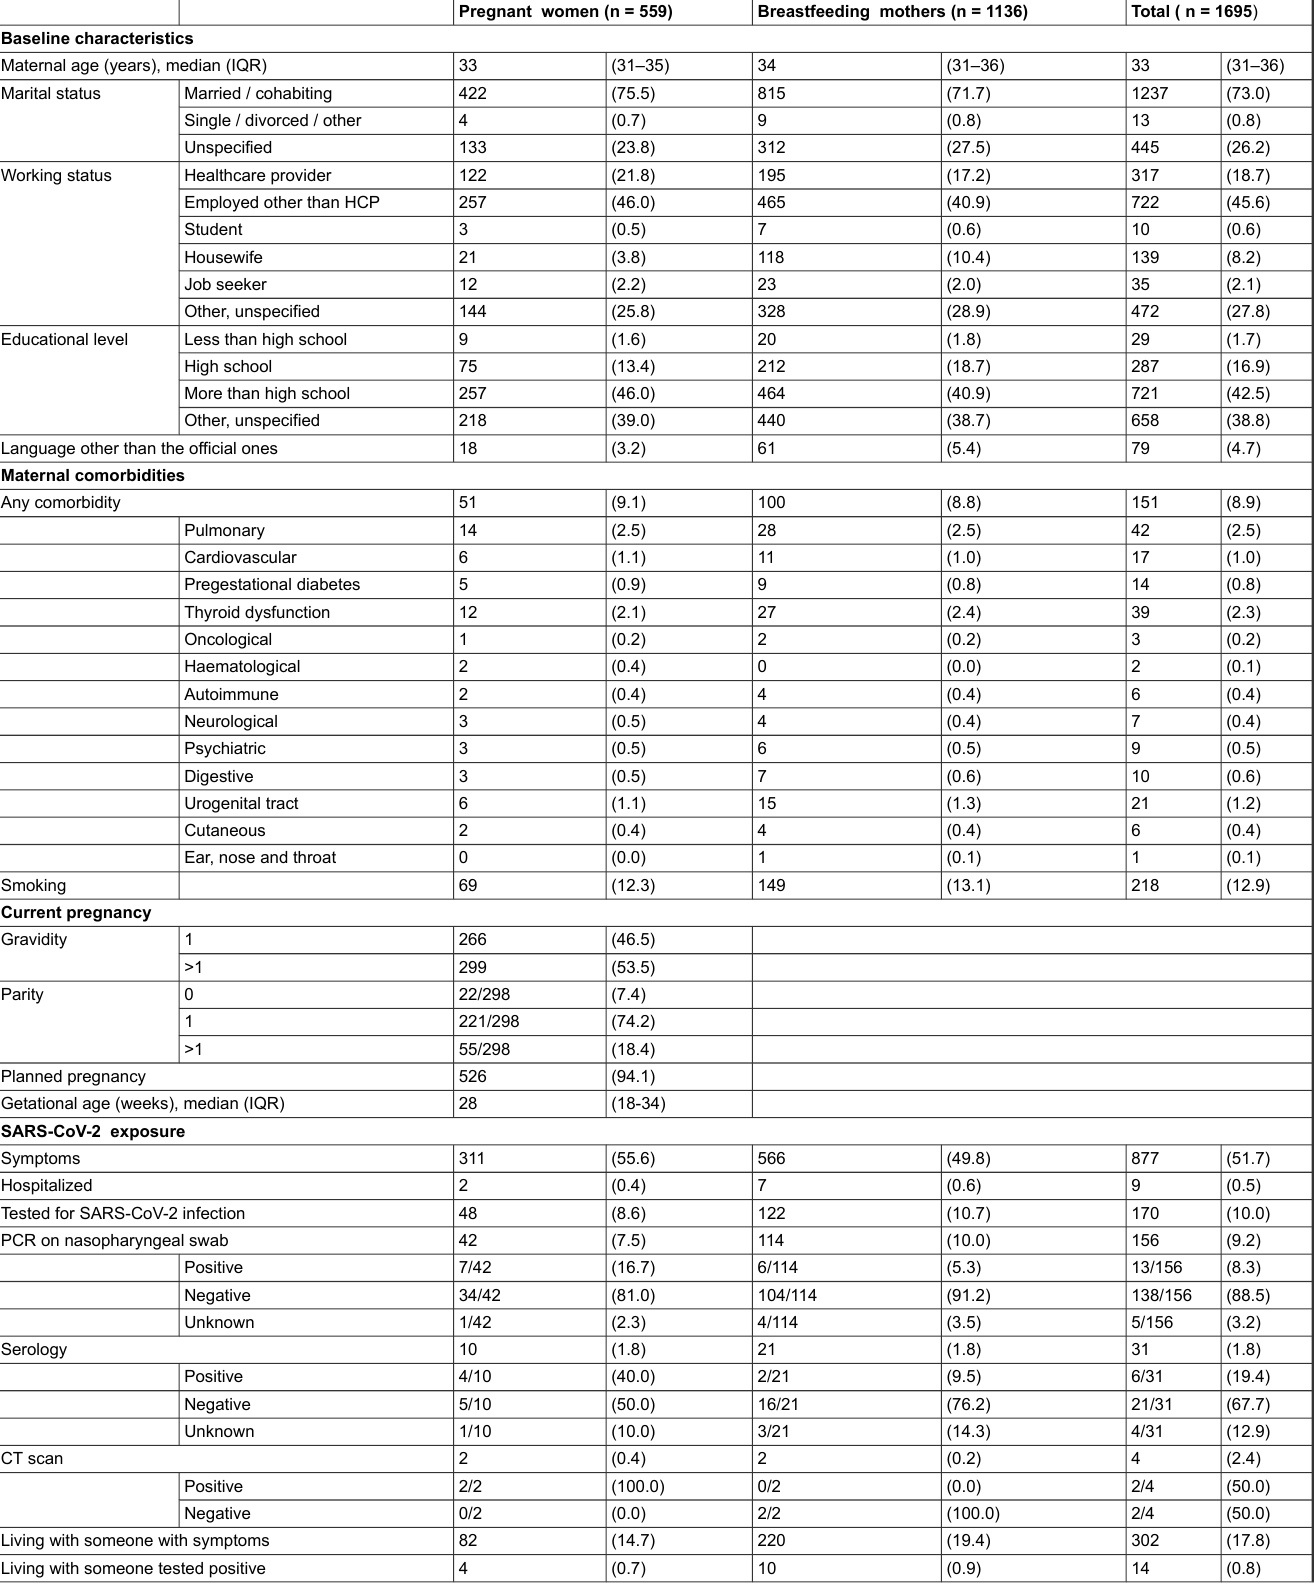
Table 1: Baseline and pregnancy characteristics, maternal comorbidities and SARS-CoV-2 exposure among 1695 participants.